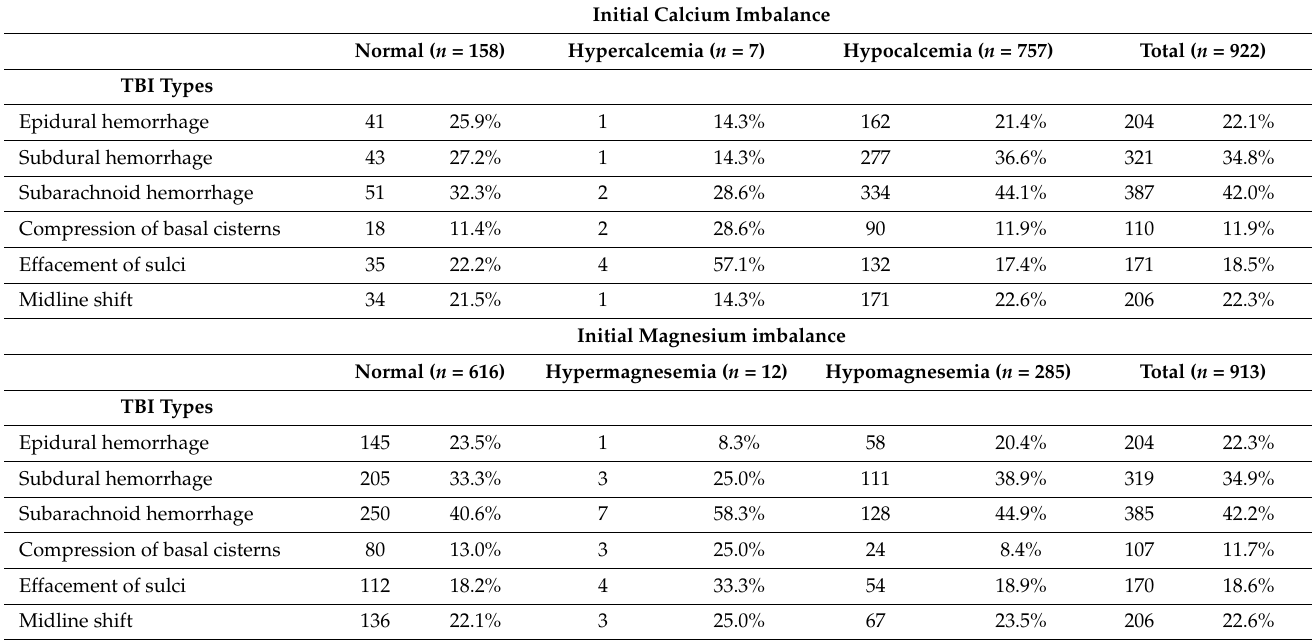
Table 3. Electrolyte imbalance based on the type of Traumatic Brain Injury